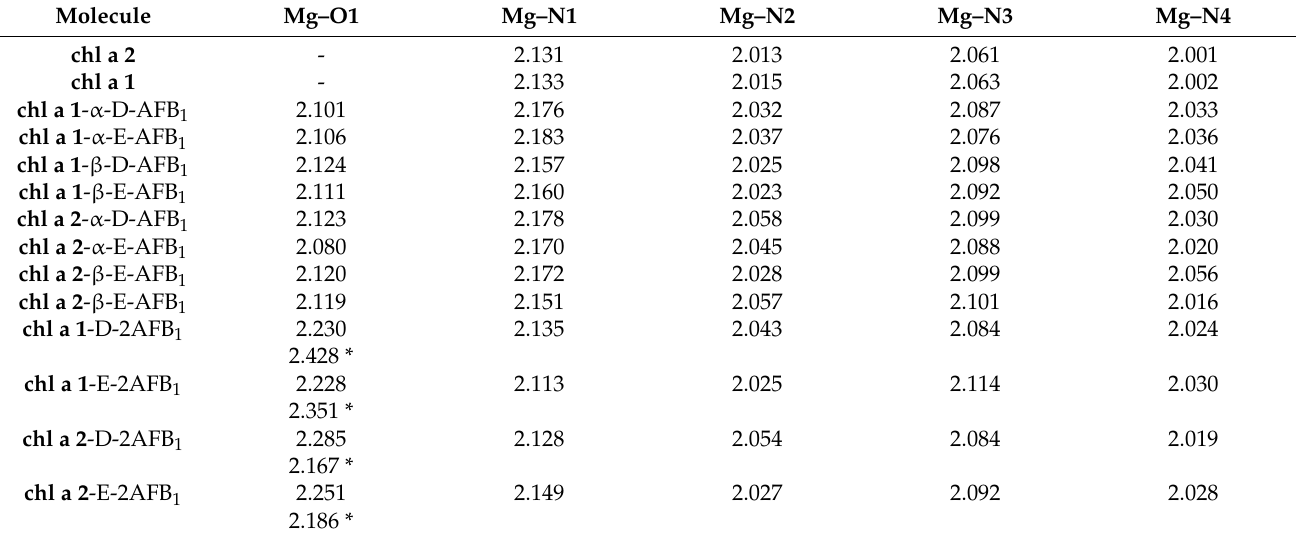
Table 1. Bond distances, in Å, of optimized